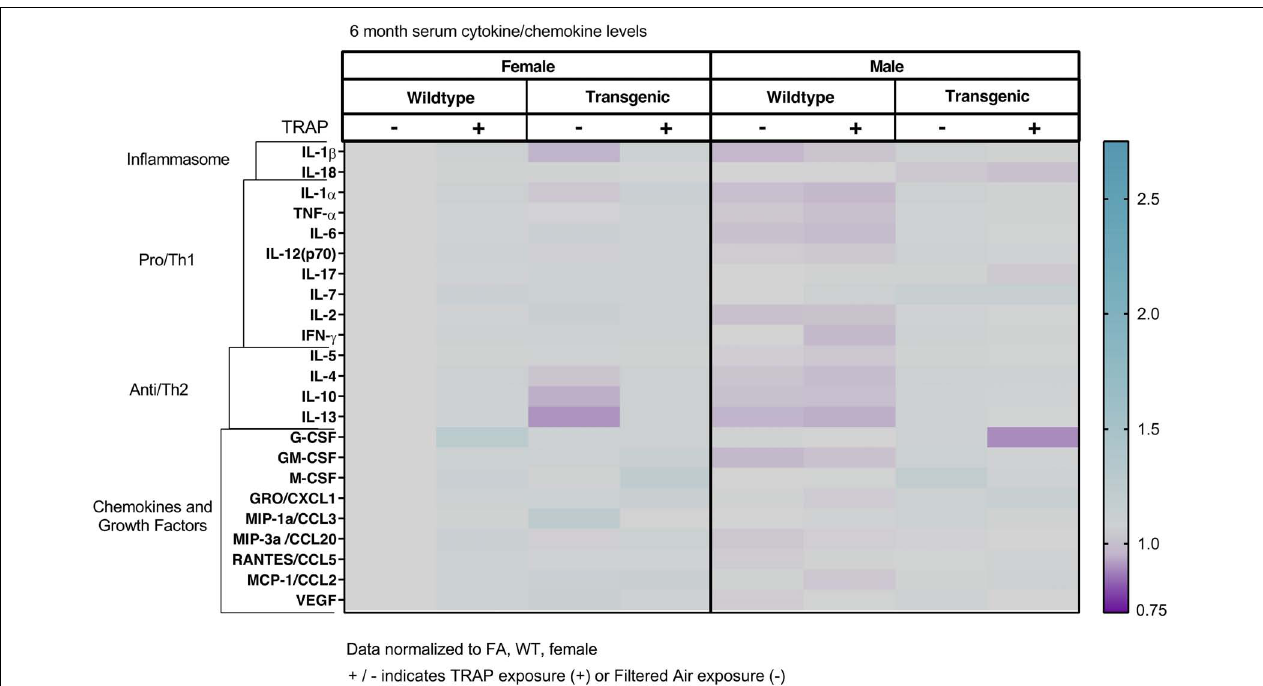
FIGURE 3 | Heat map representation of serum cytokine, chemokine, and growth factor changes in response to TRAP in 6-month old TgF344-AD and WT rats. Serum levels of cytokines and growth factors in TgF344-AD and WT rats exposed to FA or TRAP for 5 months were analyzed using multiplex technology. For each analyte, individual values were normalized to the mean level of that same analyte in sera from female FA WT animals. Purple indicates normalized protein levels < 1.0; turquoise indicates normalized protein levels > 1.0. ± indicates exposure with + identifying TRAP-exposed animals; - indicating FA-exposed animals; n = 4–5 animals per group (duplicate samples were analyzed for each animal). Non-normalized cytokine values for female FA WT animals are provided in Supplementary Table 1